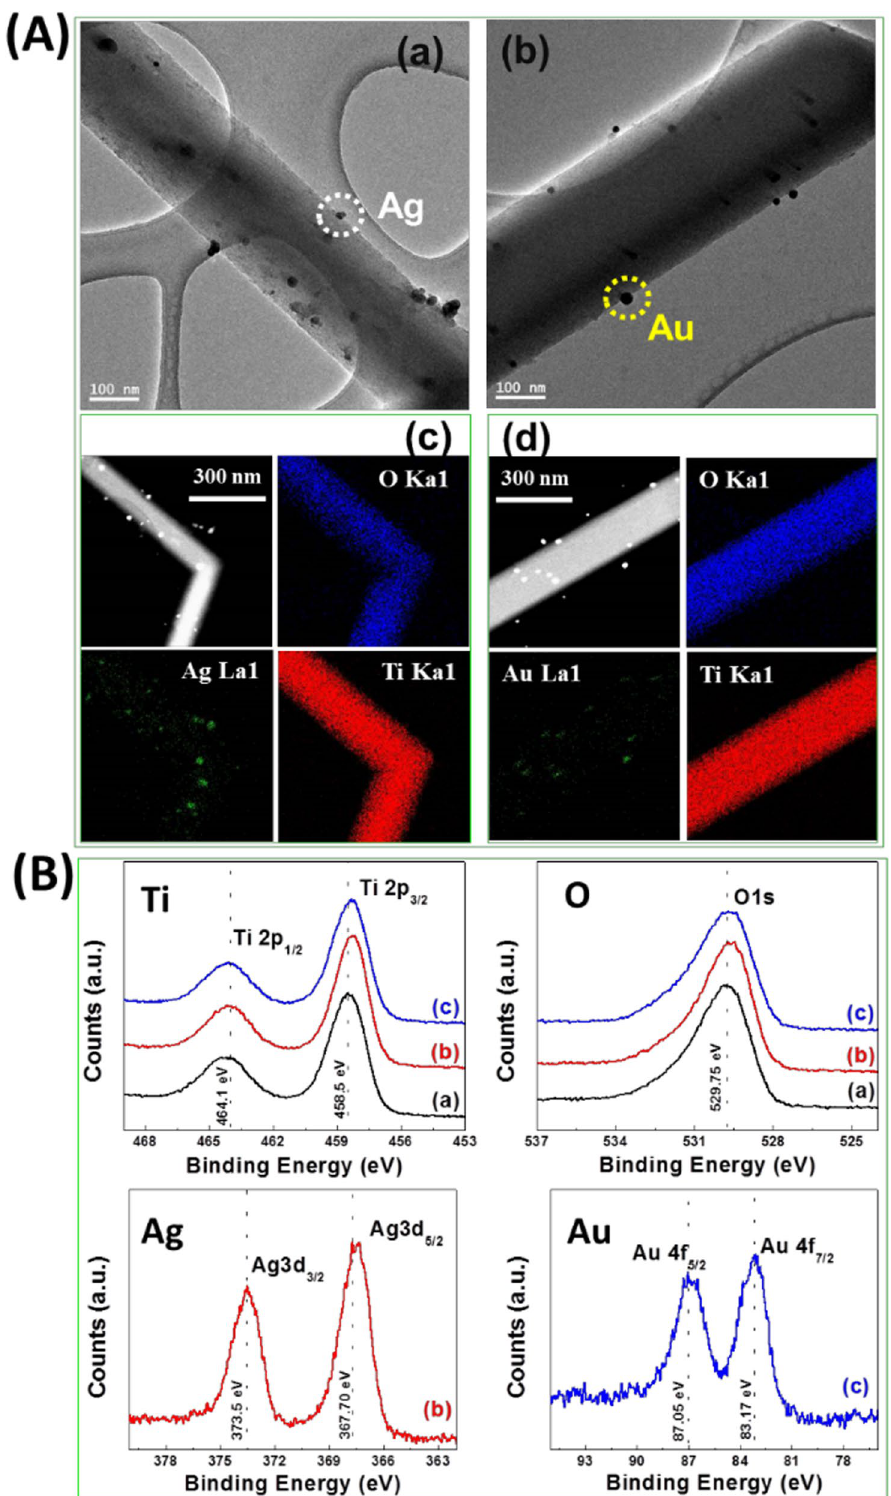
Fig. 2 Nanoparticle attachment to TiO 2 NRs as determined by electron microscopy. A TEM images of (a) silver (Ag) nanoparticle‑loaded TiO 2 NRs and (b) gold (Au) nanoparticle‑loaded TiO 2 NRs. Dotted circles show Ag and Au nanoparticles on the surfaces of TiO 2 NRs. (c) and (d) show respective TEM maps. B High‑resolution XPS spectra of Ti 2p, O 1s, Ag 3d, and Au 4f oxidation peaks of (a) bare TiO 2 NRs, (b) Ag‑loaded TiO 2 NRs, and (c) Au‑loaded TiO 2